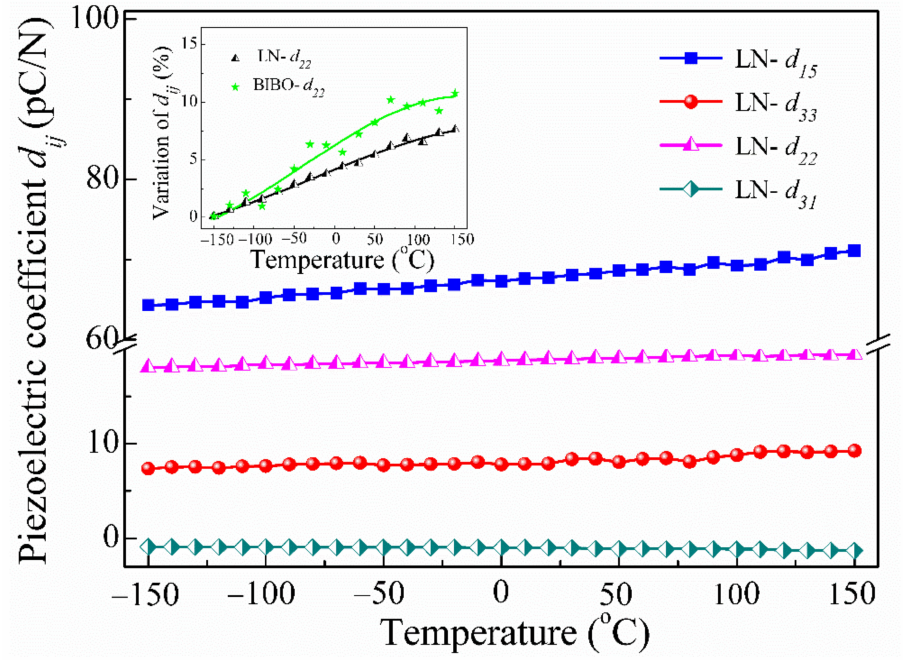
Figure 5. Variation of piezoelectric coefficient d ij for LN